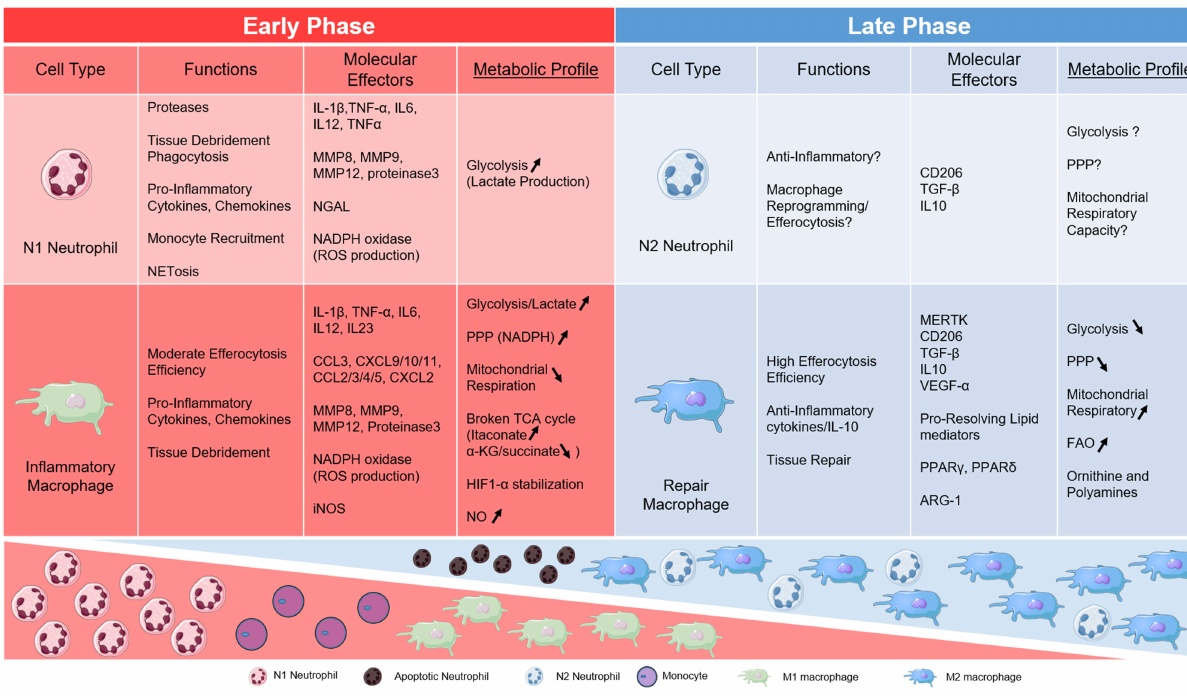
FIGURE 1 | Table of metabolic links to key phagocytes during AMI. Neutrophil and Macrophage subsets are divided into early and late phases of cardiac inflammation after myocardial infarction and according to metabolic phenotype.